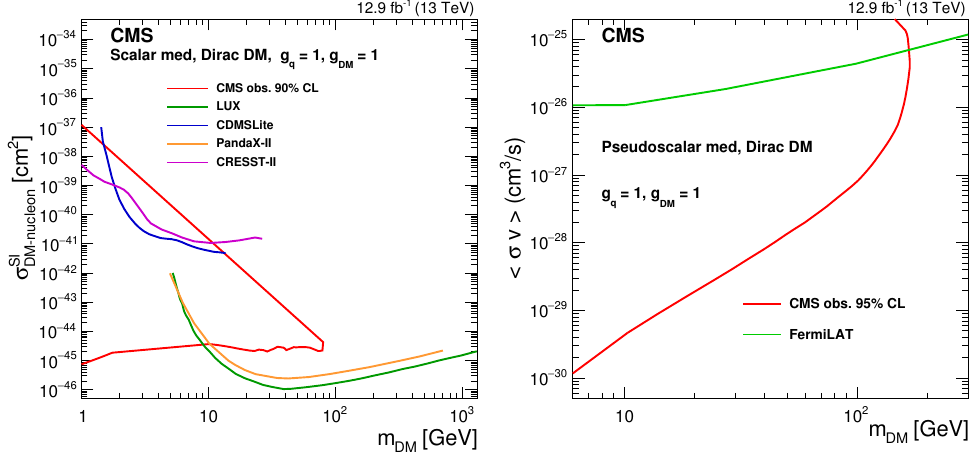
Figure 12 . Exclusion limits at 90% CL in the m DM vs. (cid:27) SI/SD plane for the scalar mediator model (left). The observed exclusion in this search (red line) is compared to the results from the CDMSLite [91], LUX [92], PandaX-II [93], and CRESST-II [94] experiments. For the pseudoscalar mediator (right), limits at 95% CL are compared to the velocity-averaged DM annihilation cross section upper limits from Fermi-LAT [90]. There are no comparable limits from direct detection experiments as the scattering cross section between DM particles and SM quarks is suppressed at nonrelativistic velocities for a pseudoscalar mediator [99, 100].